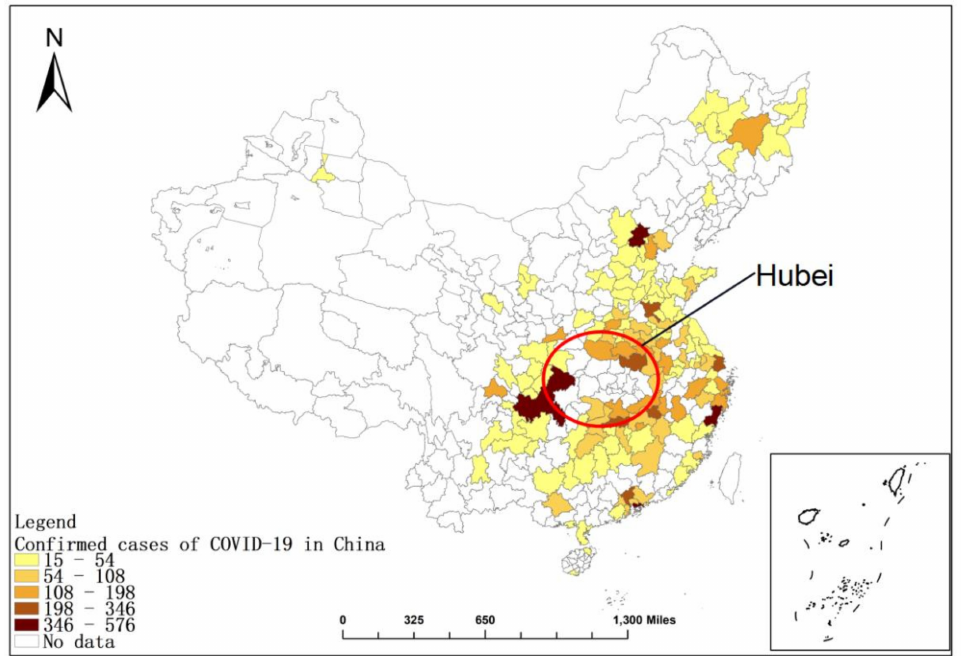
Figure 1. Cumulative confirmed cases of COVID 19 in China. (Note: The base map is from the National Bureau of Surveying and Mapping Geographic Information (http://bzdt.nasg.gov.cn) (accessed on 7 May 2022). We ensure that we have obtained the permission and there is no copyright